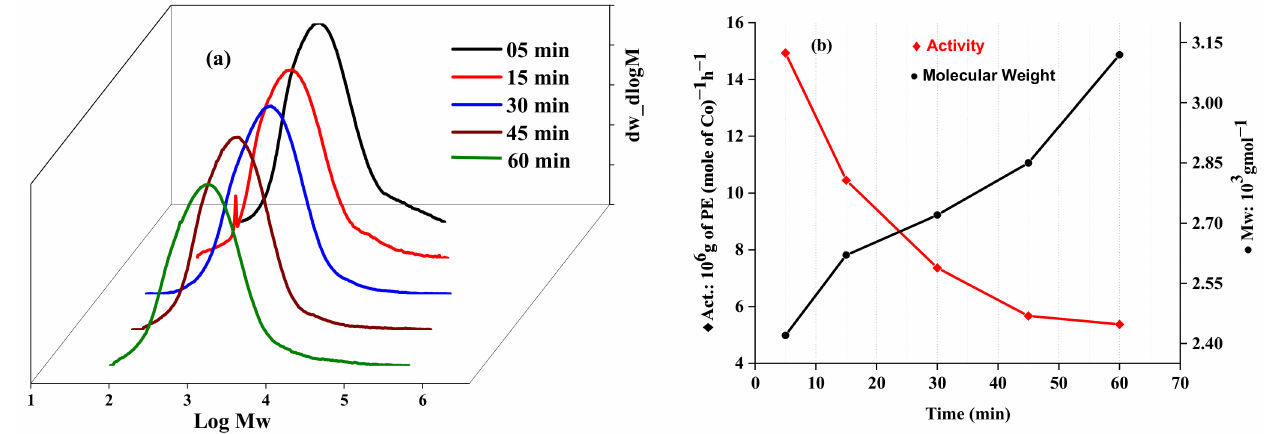
Figure 5. GPC curves of the obtained polyethylene ( a ); activity and M w as a function of reaction time ( b ) for the Co1 /MAO system (Table 2, entries 7,